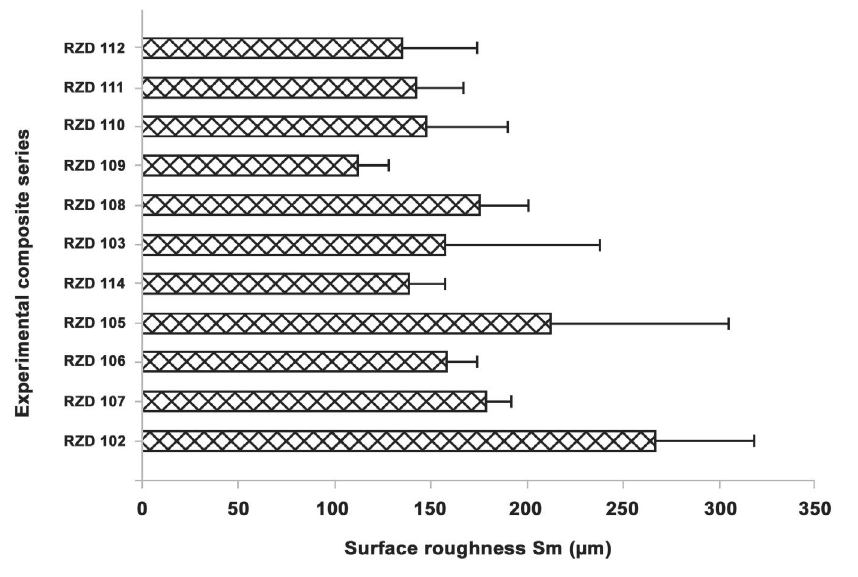
Figure 3- Surface roughness, Sm ( µ m) of the mono-, bi- and multi-modal experimental composite